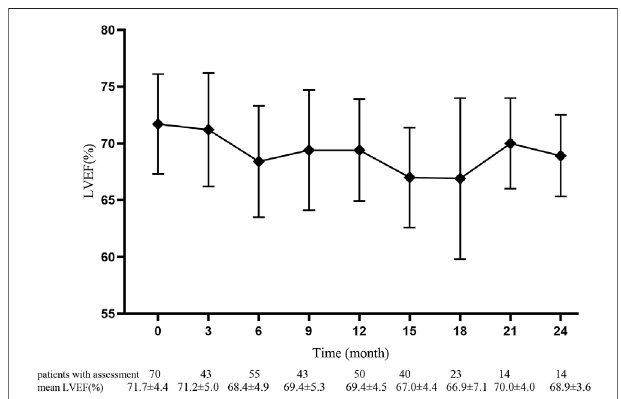
FIGURE 1 | Pre-anthracycline baseline and value of left ventricular ejection fraction in 70 patients at each monitoring timepoint. Data are presented as mean ± standard deviation.